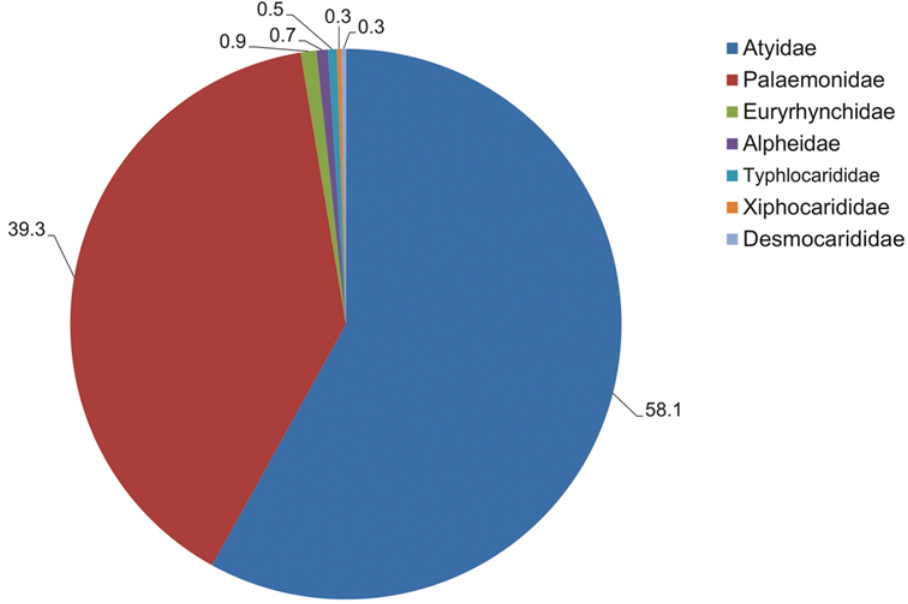
Fig 2. Freshwater shrimp species richness across the constituent families, expressed as a percentage of global fauna.